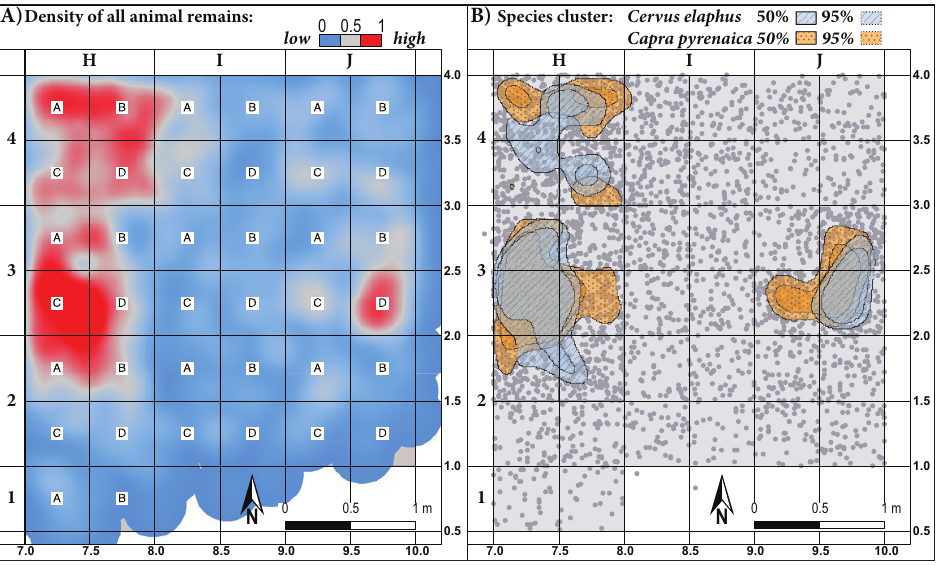
Figure 4: The spatial distribution pattern of faunal remains shows: A) generally high den- sities corresponding to hotspots in meter- squares H3, H4 and J3; B) that the spatial distribution clusters of high densities of the two main game species, Cervus elaphus and Capra pyrenaica , largely overlap and indicate similar processing or discarding activities (Grey points mark individual faunal